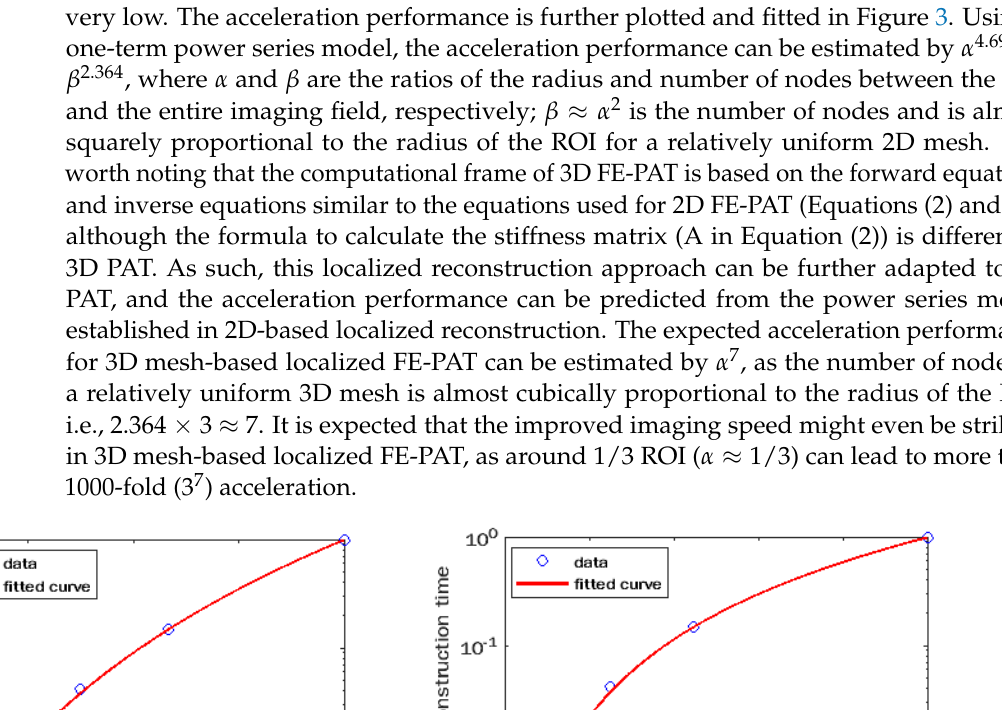
Figure 3. Acceleration performance and fitted curves of the localized FE-PAT algorithm in terms of the relative radius ( a ) and the relative number of nodes ( b ) in the ROI. The ordinates are based on a logarithmic scale.